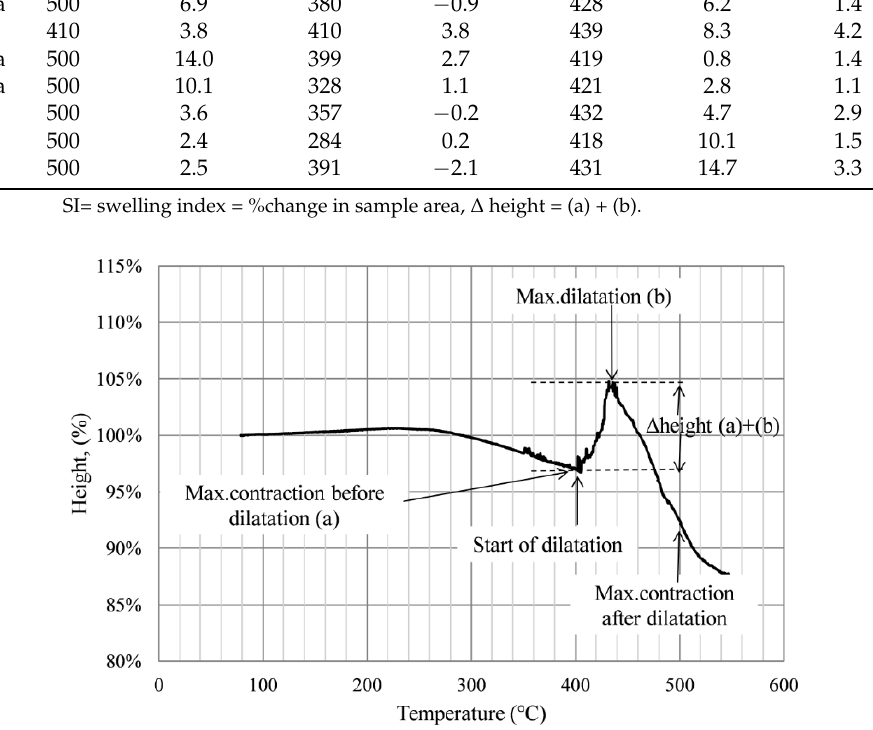
Table 4. Dilatometer and Gieseler test data for the coal blends before carbonization in technical scale at DMT. All blends contain HV2 coal, i.e., BB2 T .